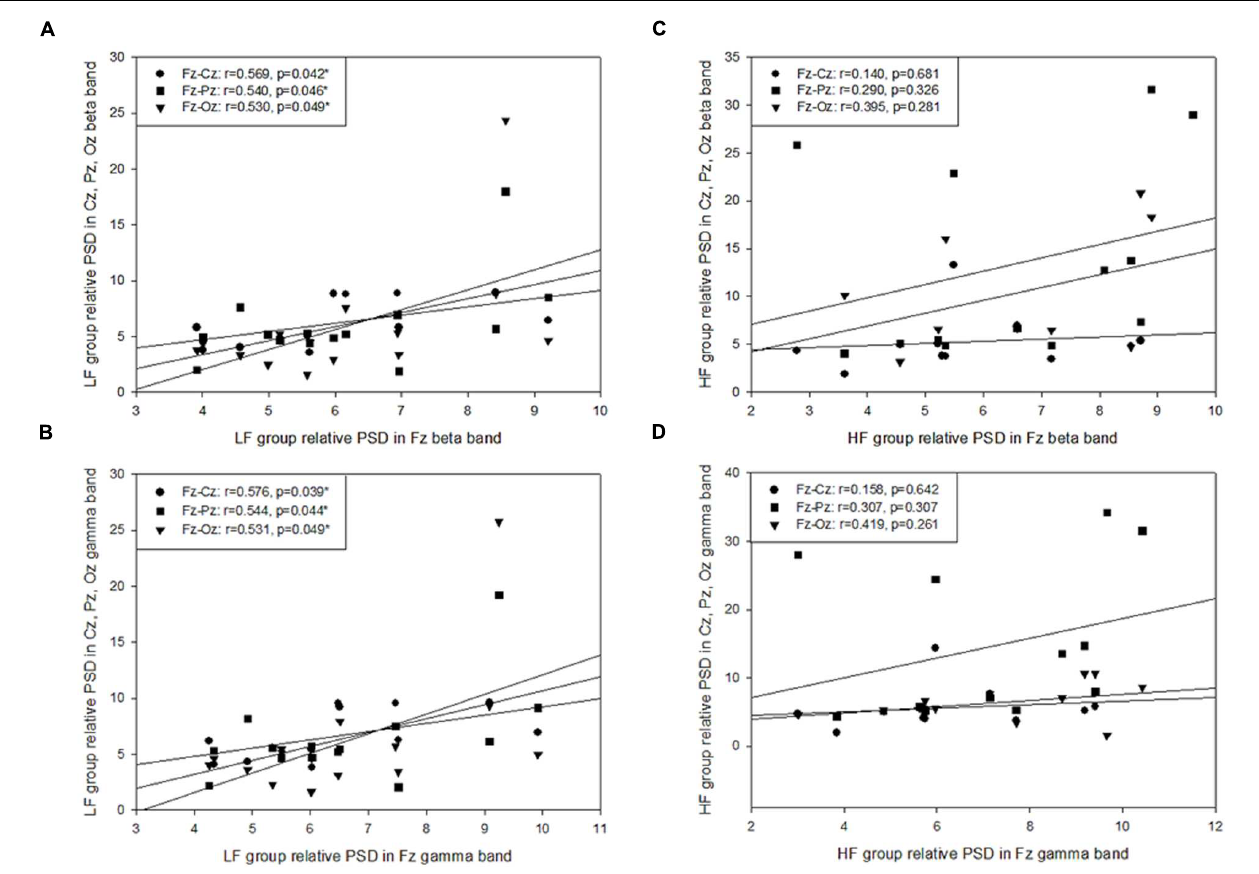
FIGURE 5 | Pearson’s correlation coefficient analysis of the posture-related cortex regions during the platform recovery phase with virtual reality interference. The LF group demonstrated a significant correlation at Fz site and other regions in (A) the beta band and (B) the gamma band; however, there was no relationship found during the platform recovery phase among the HF group (C,D)